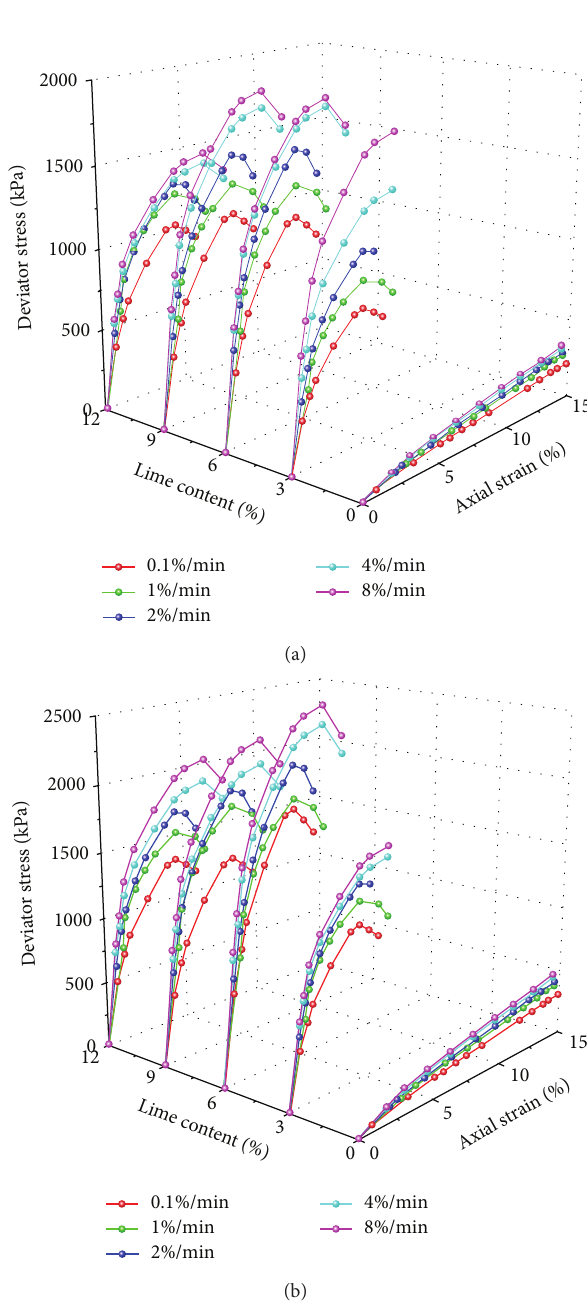
Figure 3: Stress-strain curves with different loading rates and lime contents of (a) 7 days and (b) 21